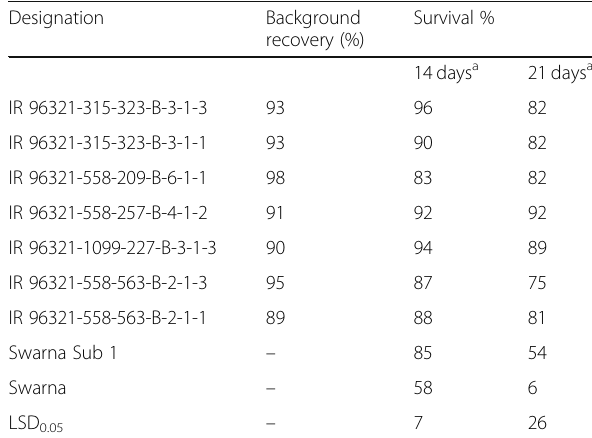
Table 5 Survival percentage (%) of NILs screened at Patna in 2015DS under submergence